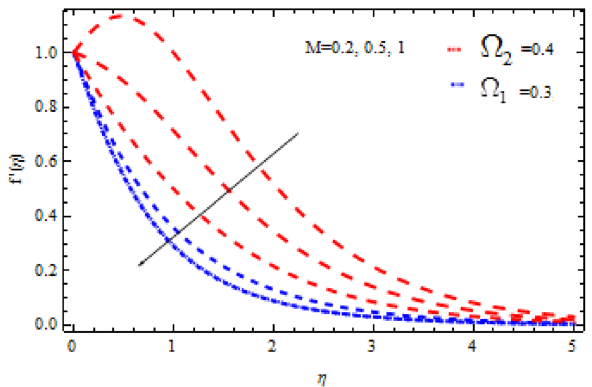
Figure 8. Consequence of M on f ′ .